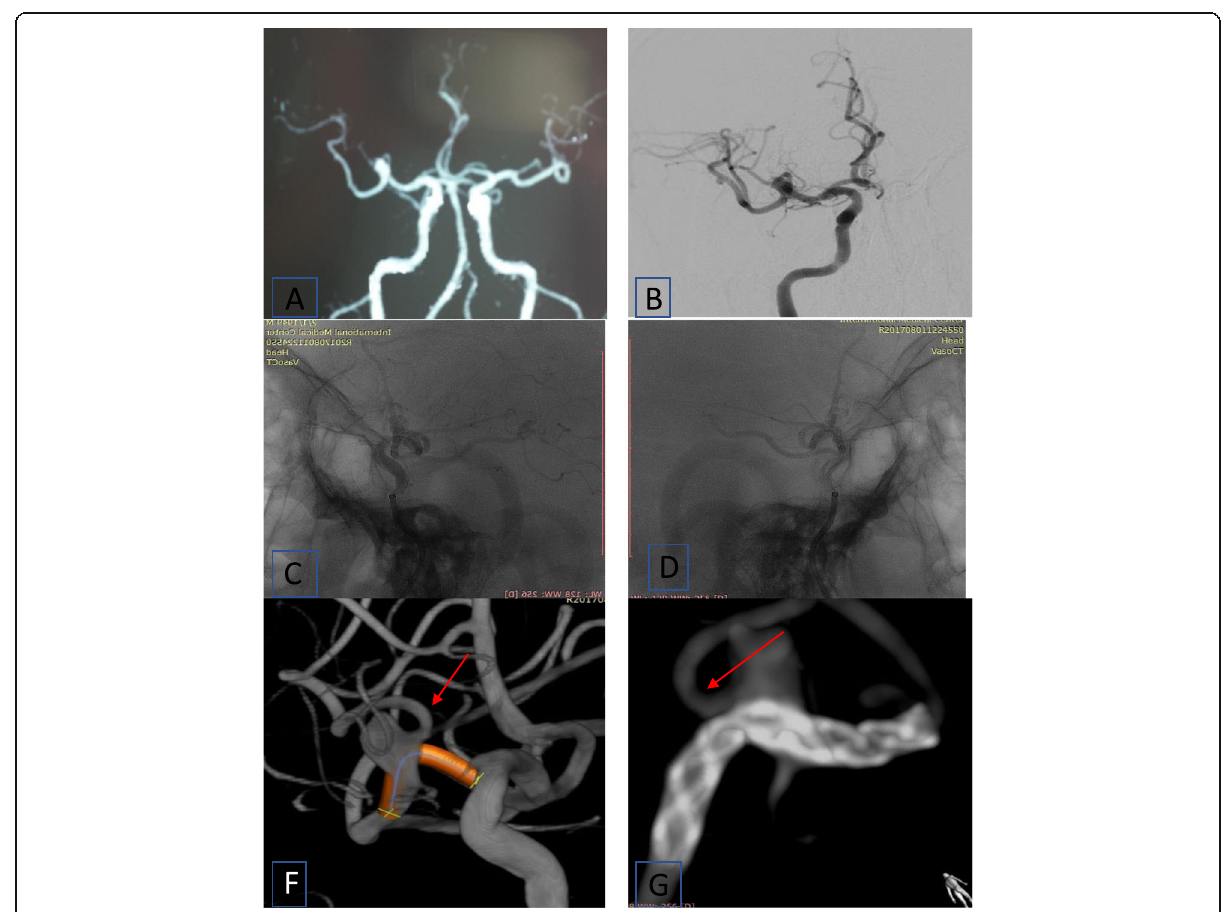
Fig. 7 Example of flow diverter stent in wide neck M1 aneurysm with a branch arising from the sac. Immediately after the procedure, the patient develops left hemiplegia which raises the suspicion of thromboembolic complication. DSA revealed patent stent with slowing down of the flow within the covered branch (red arrow), no stent thrombosis; this was corrected by elevation of the patient blood pressure. Complete occlusion of the aneurysm was achieved with no complications. A Reconstructed MDCT image showing M1 aneurysm with aneurysmal branch from the sac. B A-p view DSA, showing the aneurysm and the sac branch. C Just after deployment of the stent. D Slowing down of the flow in the aneurysmal branch. E Road mapping for the stent deployment. F Vaso-CT after stent deployment